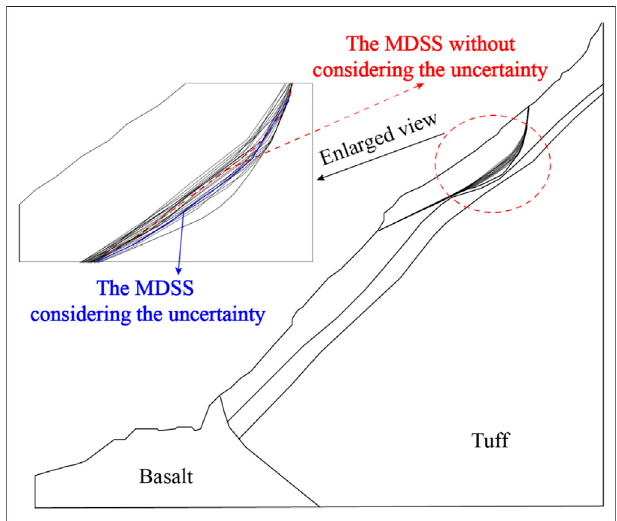
FIGURE 7 | Distribution of the critical slip surfaces.